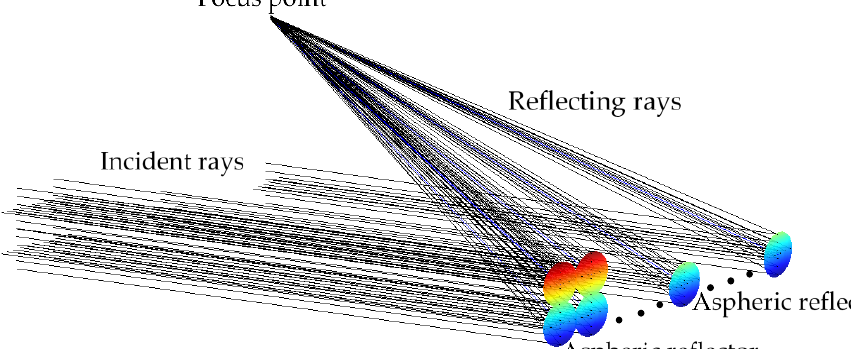
Figure 1. The focusing system consists of multiple aspheric reflectors.